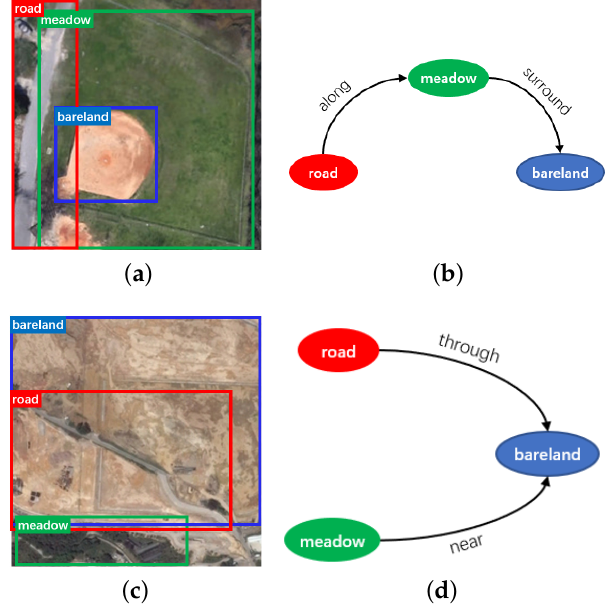
Figure 1. The comparative illustration of object detection and scene graph. ( a ) The object detection result of baseballfield, in which nodes are annotated with region boxes and the belonging categories. ( b ) The scene graph corresponding to baseballfield, where the solid ellipses represent nodes and the lines with arrows represent the interactive relationships among nodes. ( c ) The object detection result of desert. ( d ) The scene graph corresponding to